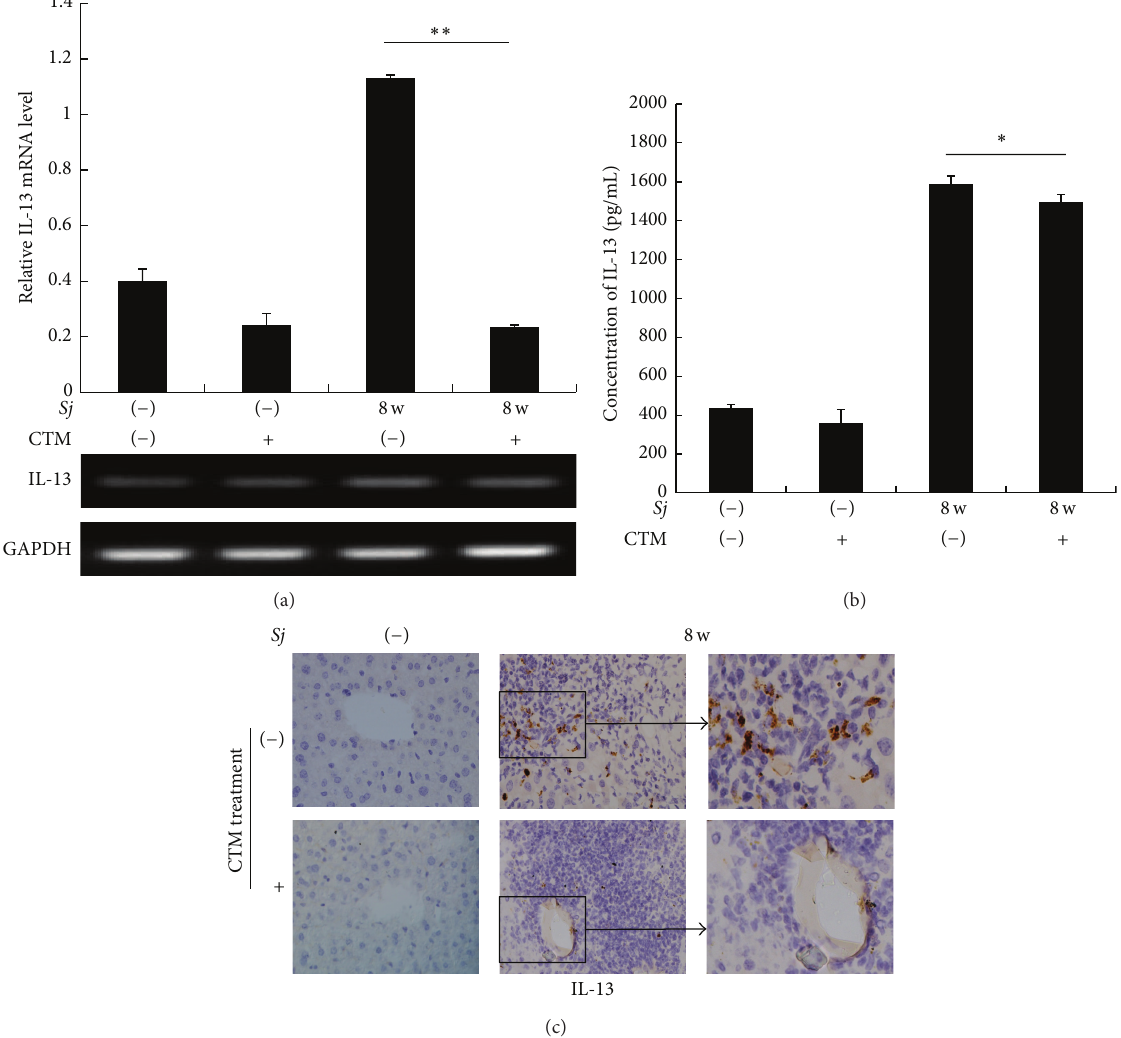
Figure 5: CTM reduced IL-13 expression profile in the mice liver during Sj infection. Mice are sacrificed at week 8 after Sj infection and their liver or sera are collected. (a) IL-13 mRNA level in mouse liver of normal or Sj -infected mice with or without CTM treatment is detected by RT-PCR and Q-PCR. Upper panel: Q-PCR; lower panel: RT-PCR. GAPDH is detected as an internal control. Data are presented as mean ± SD from eight mice per group. ∗∗ 𝑃 < 0.01 . (b) IL-13 concentration in mouse sera of normal or Sj -infected mice with or without CTM treatment is detected through ELISA. Data are presented as mean ± SD from 8 mice per group. ∗ 𝑃 < 0.05 . (c) Mouse livers at indicated time points are fixed in paraformaldehyde, embedded in paraffin, sliced, and IHC stained for IL-13. Representative slices of IHC staining for IL-13 are shown at original 40x